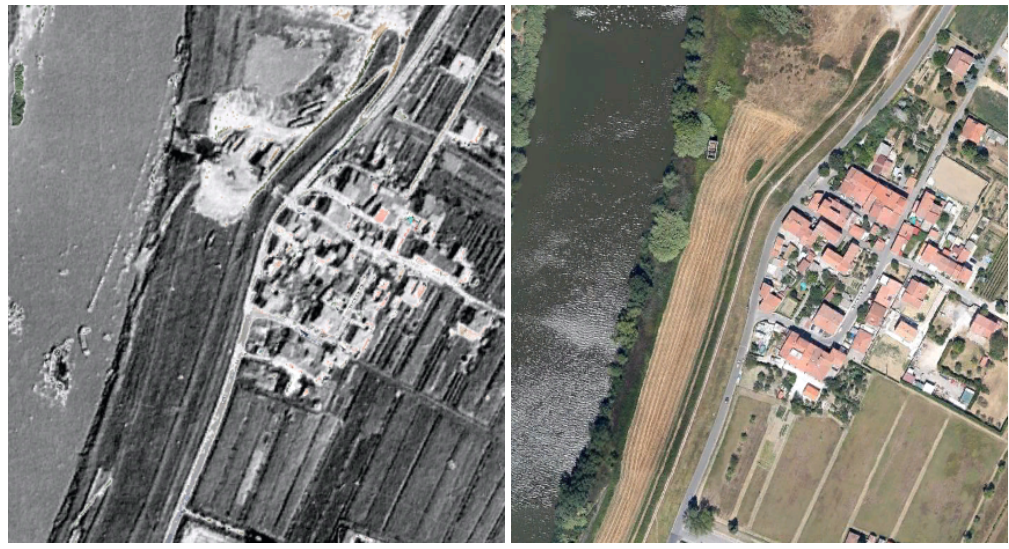
Figure 18. Left : The ruins of the San Savino abbey are visible in the water of the Arno river (lower-left corner). Right : The Arno river and the town of Riglione today ( c (cid:13) Marcello Cosci Aerial Photography Documentation Centre. c (cid:13) 2010